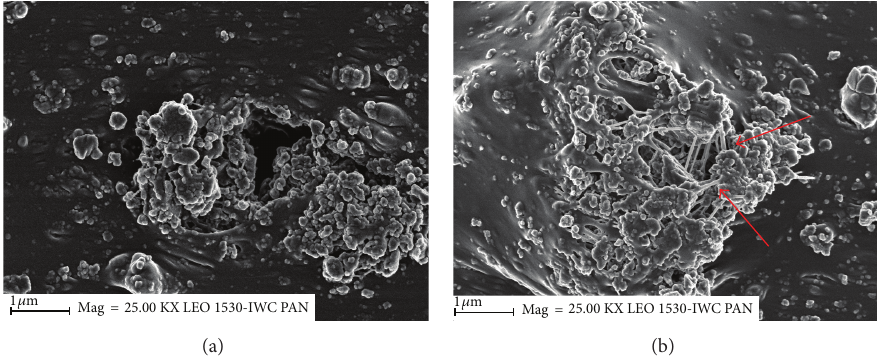
Figure 4: SEM images of (a) standard, (b) sample II (Mag—magnification × 25000). In (b), the arrows show the possible interactions between molecules of keratin and rubber or other elastomeric components of the